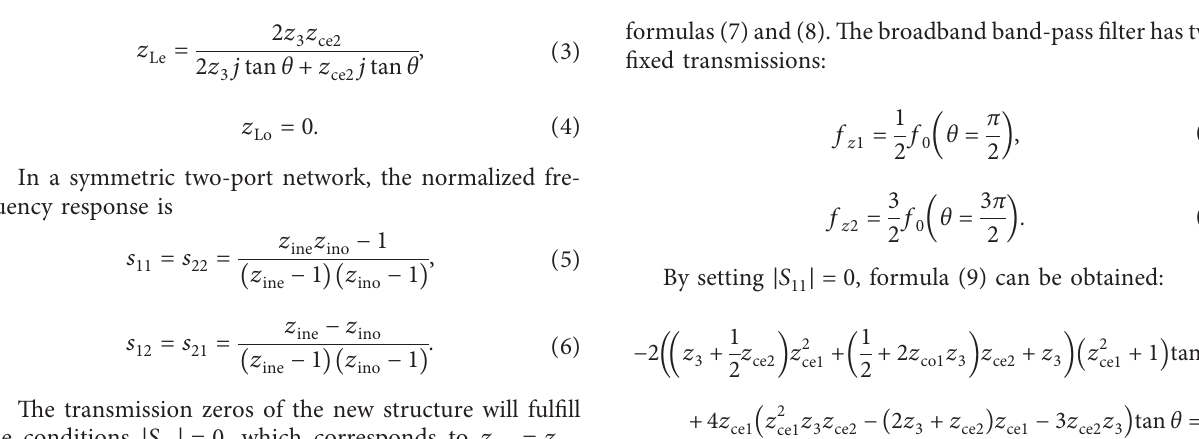
, (b) z , and (c) z ce1 ce2 3